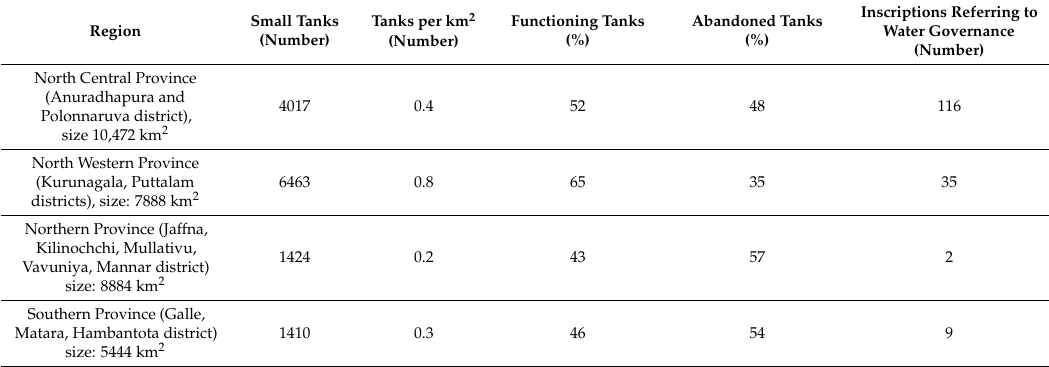
Table 7. Distribution of small tanks in different provinces (modern Sri Lanka) [83] and number of inscriptions referring to water governance. Region Small Tanks (Number) Tanks per km